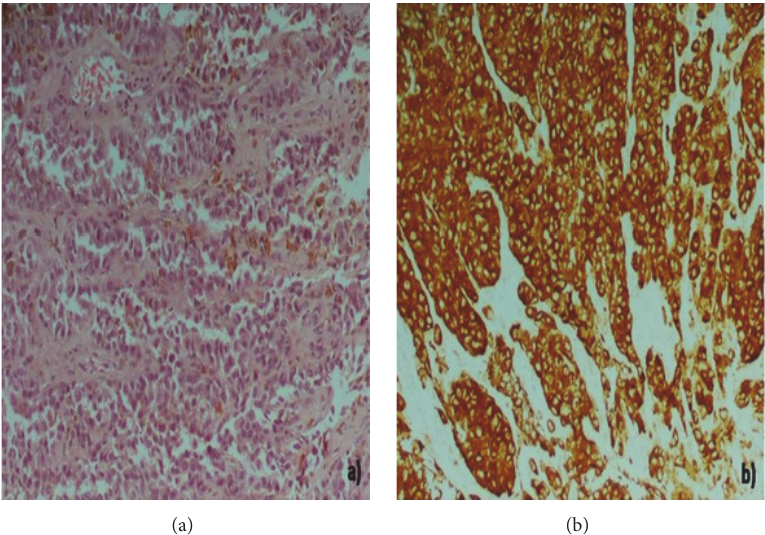
Figure 3: (a) Bronchial biopsy with infiltration by atypical melanocytes containing melanin pigmentation ( H&E, magnification × 200 ). (b) Immunohistochemical expression of Melan A in neoplastic cells ( DAB, magnification × 200